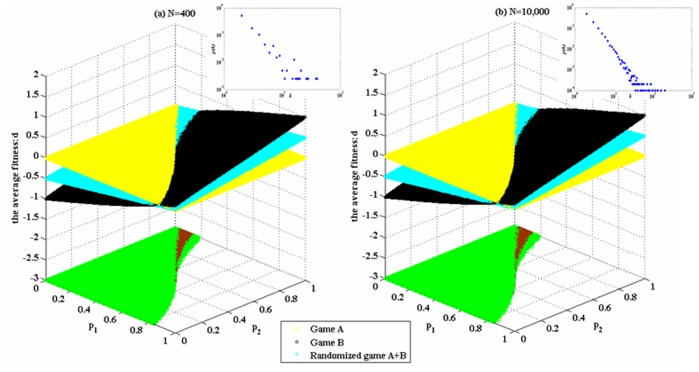
The influence of the network size on the Parrondo effect (based on the BA scale-free network).The average degree of the network is four and the average number of playing times T of each individual is 100. The probability of playing game A is p = 0.5. Play the games 30 times with different random numbers, and draw the corresponding figures according to the average results of the games. The small window in the figure shows the degree distribution of the nodes. The green area in the figure represents the area of the weak Parrondo’s paradox, whereas the brown region denotes the strong area. The population size N of Figure 7 (a) is 400 and Figure 7 (b) is 10, 000, respectively.